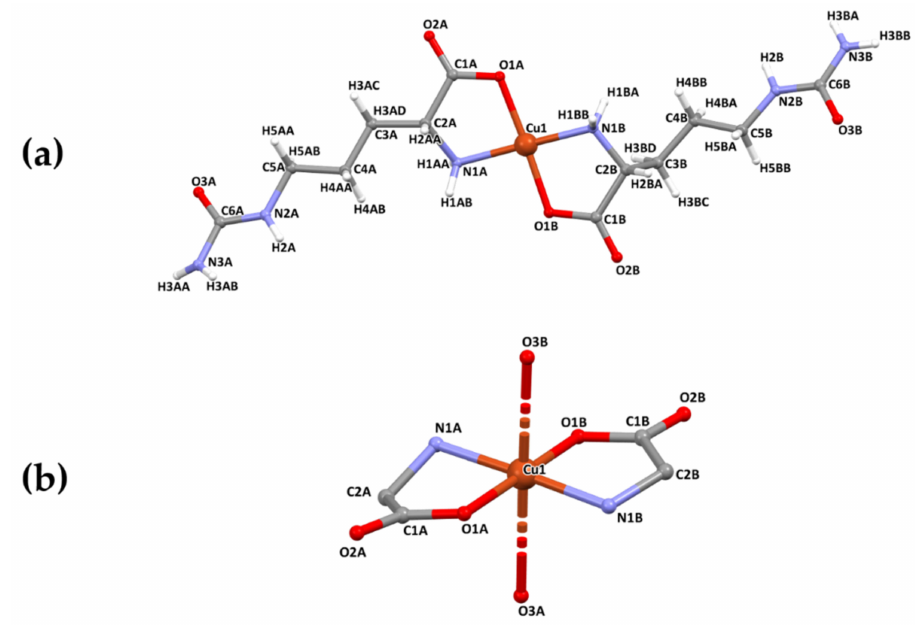
Figure 1. ( a ) Asymmetric unit of [Cu(Citr) 2 ] n . ( b ) Detail of the coordination sphere. Color code: copper (brown), oxygen (red), nitrogen (blue), carbon (grey), and hydrogen atom